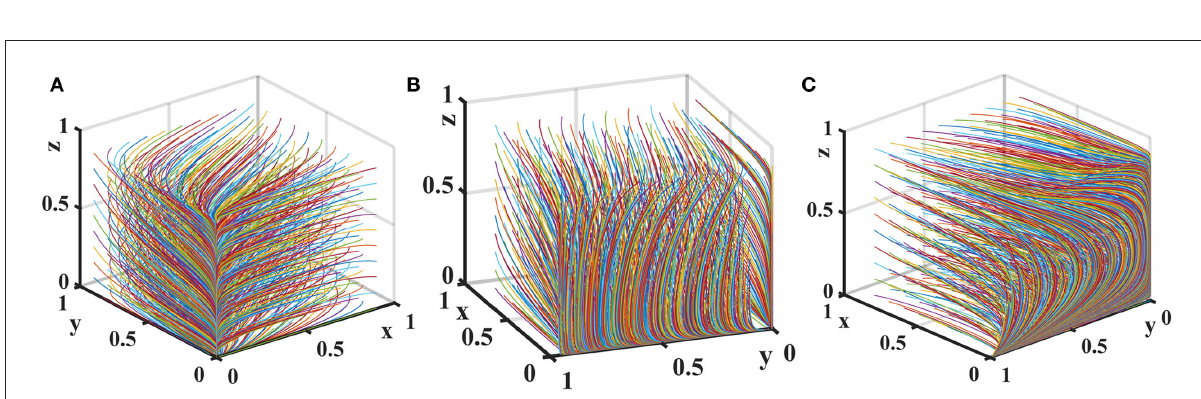
FIGURE7 Impact of T on the evolution of each player’s strategy. Figure is the simulation diagram that shows the influence of the unit cost of exchanging goods of pharmaceutical enterprises on the strategic choices of government regulator, pharmaceutical enterprises, and medical institutions. (A) When T = 0; (B) when T = 2; (C) when T =